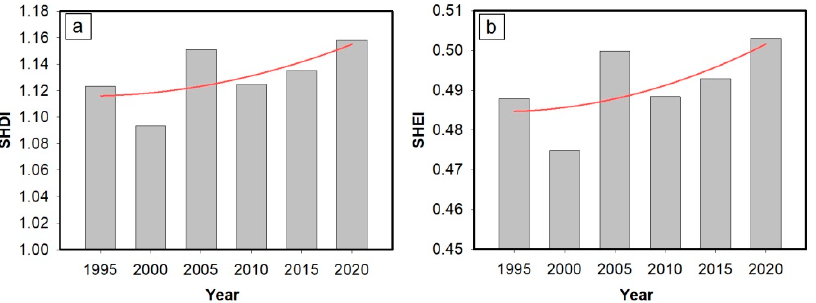
Figure 7. Landscape pattern index analysis. ( a ) SHDI of GYRR; ( b ) SHEI of GYRR. The red line in the figure is a trend line added by the authors. figure is a trend line added by the